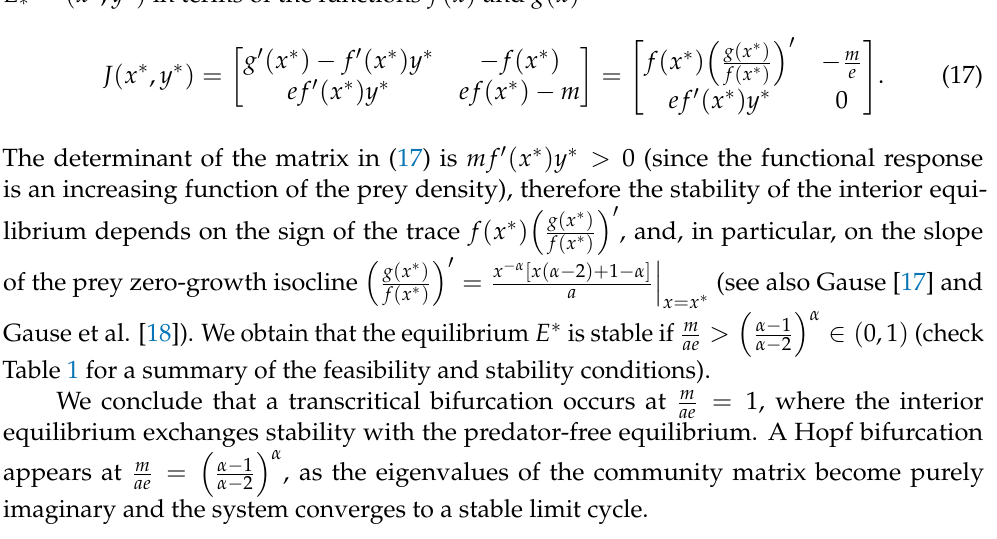
Table 1. Conditions for feasibility and stability of the equilibria of the system in (12) and (13). The trivial equilibrium E 0 is always unstable. TB: transcritical bifurcation. HB: Hopf bifurcation. Condition E 1 E ∗ Bifurcation m > 1 asympt. stable not feasible ae m = 1 TB ae (cid:16) (cid:17) α α − 1 < m < 1 unstable asympt. stable ae α − 2